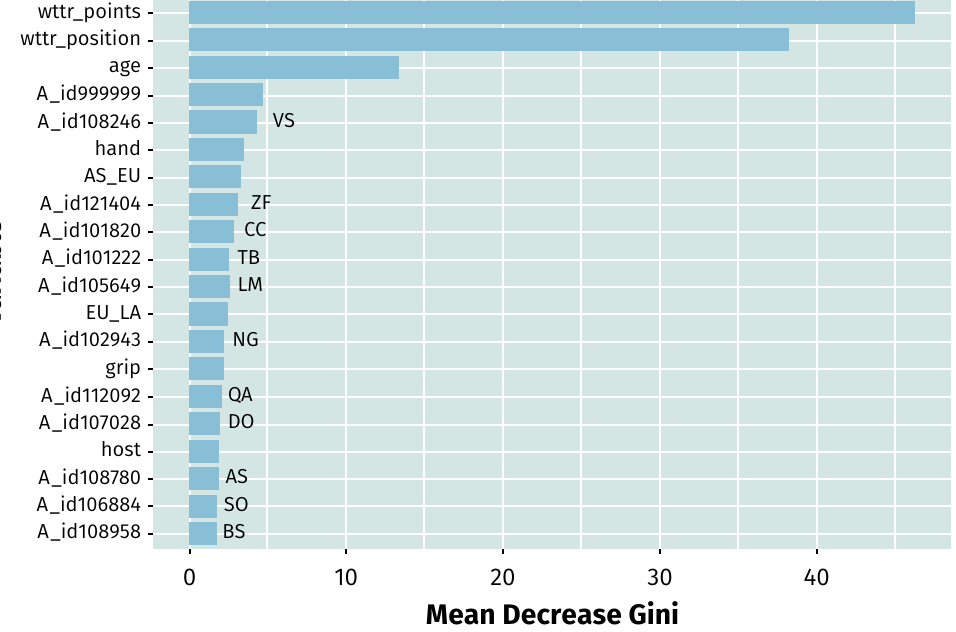
Figure 2. Variable Importance for the Random Forest Model, showing only the top 20 Variables.